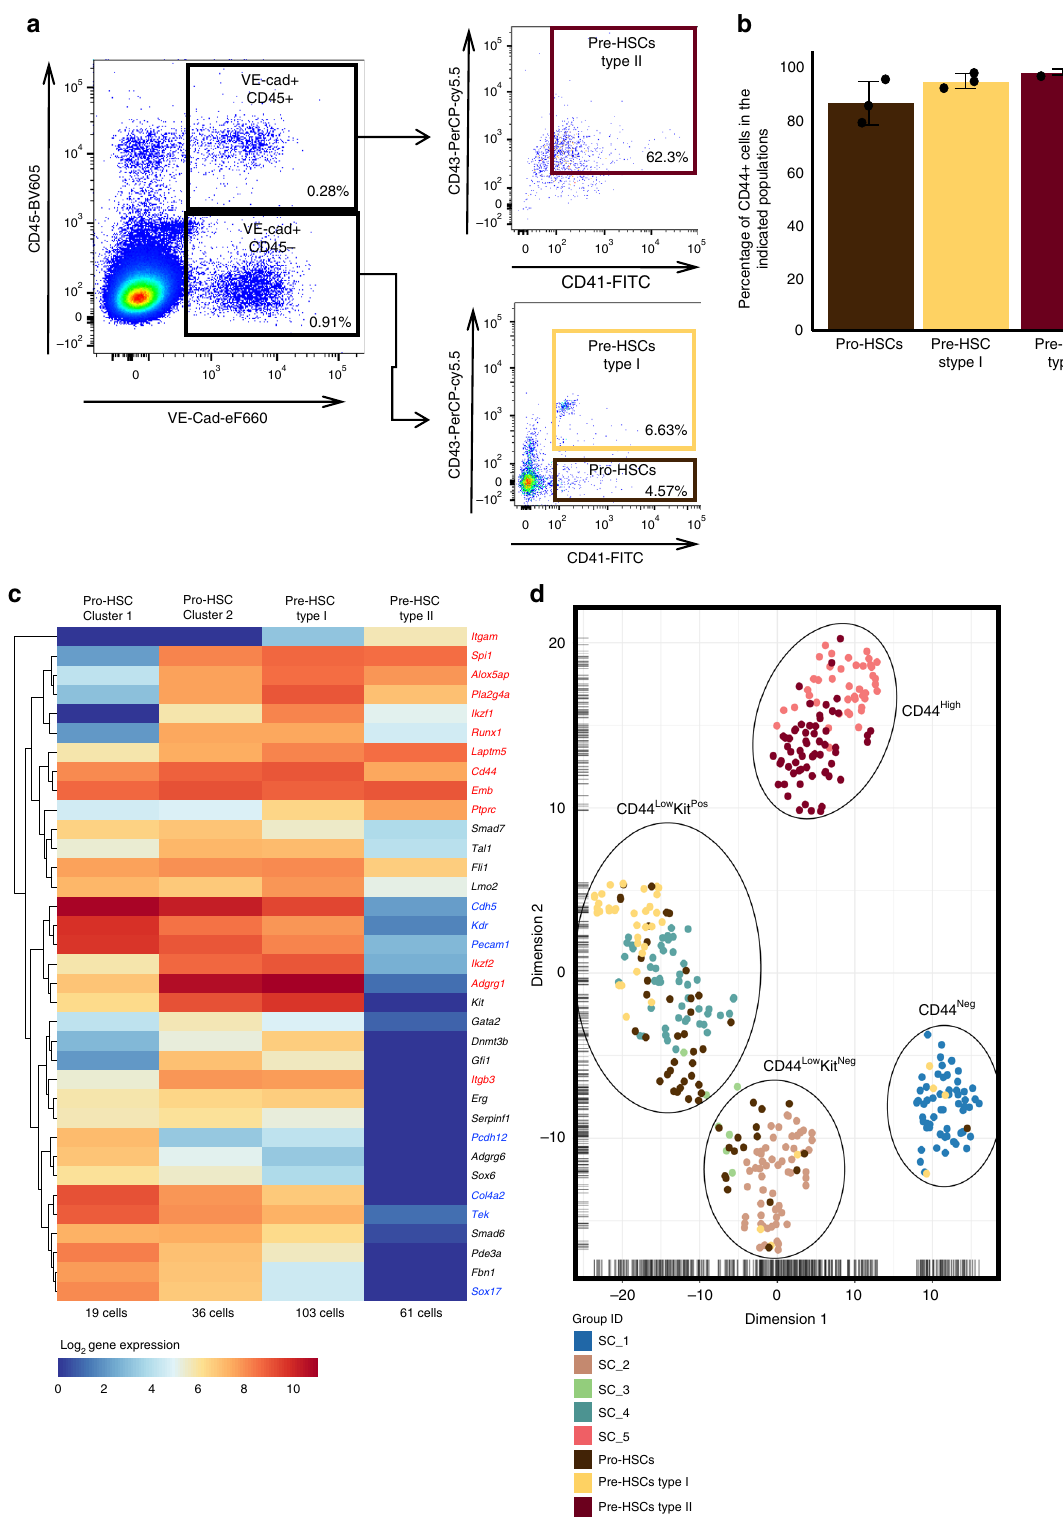
Fig. 4 Comparison of the CD44 populations with Pro-HSC, Pre-HSC type I and type II. a FACS plots of VE-Cad, CD45, CD43 and CD41 expression in the AGM region at E10 (31 − 32 somite pairs). b Average of CD44-positive frequency in Pro-HSCs, Pre-HSCs type I and Pre-HSCs type II groups ( n = 3 independent experiments). Error bars represent SD. Source data are provided as a Source Data fi le. c Single cells from Pro-HSCs (VE-Cad + CD41 + CD45 − CD43 − ), Pre-HSCs type I (VE-Cad + CD41 + CD45 − CD43 + ) and Pre-HSCs type II (VE-Cad + CD45 + ) populations were isolated and tested by single-cell q-RT-PCR. The heatmap shows the result of the hierarchical clustering analysis (the genes were clustered by Pearson ’ s correlation) based on average expression of indicated gene for each cell cluster. Genes marked in red are blood genes while the ones marked in blue are endothelial genes. d tSNE plot combining single-cell q-RT-PCR data from Figs. 3 and 4. See also Supplementary Data